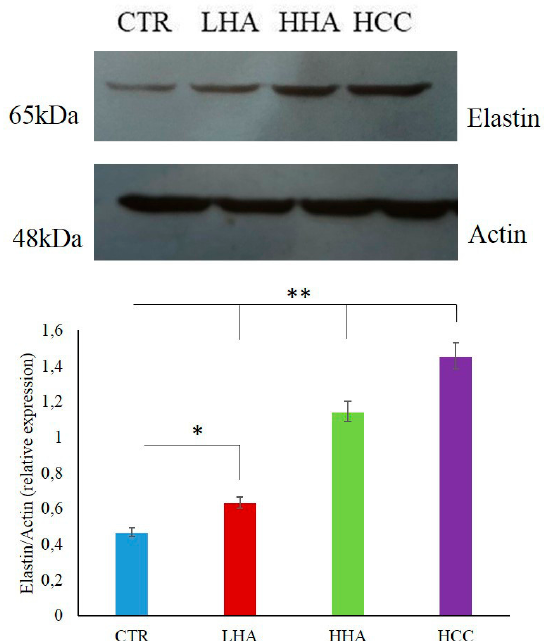
Figure 3. Effects of LHA, HHA, and HCC on elastin protein expressions in scratched HaCaT cells at 24 h in comparison with a control sample. Densitometry values are normalized with respect to actin. * p < 0.05 for LHA vs. ctr; ** p < 0.01 for HHA and HCC vs. CTR.